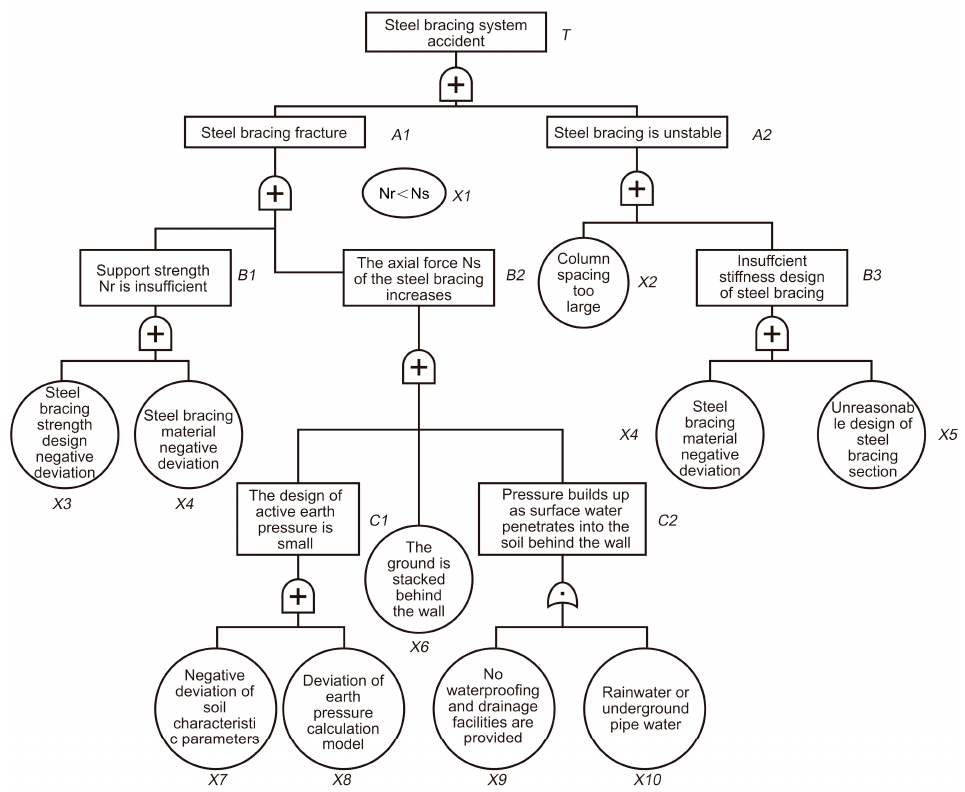
Figure 3. Accident tree of steel bracing system.